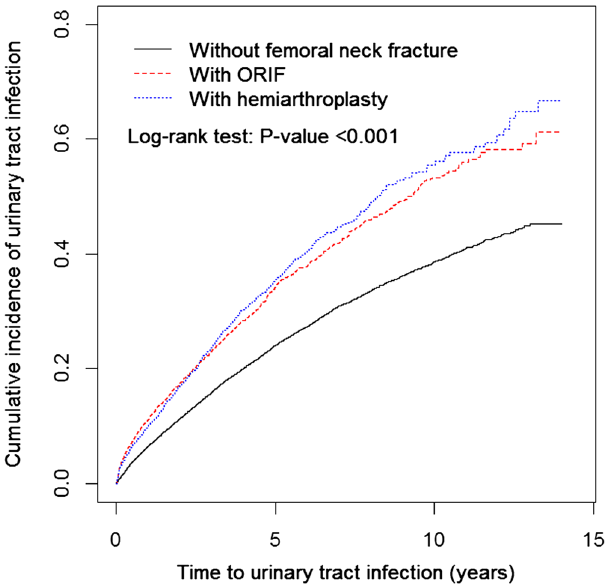
Figure 1. Cumulative incidences of urinary tract infection for ORIF, hemiarthroplasty and non-femoral neck fracture